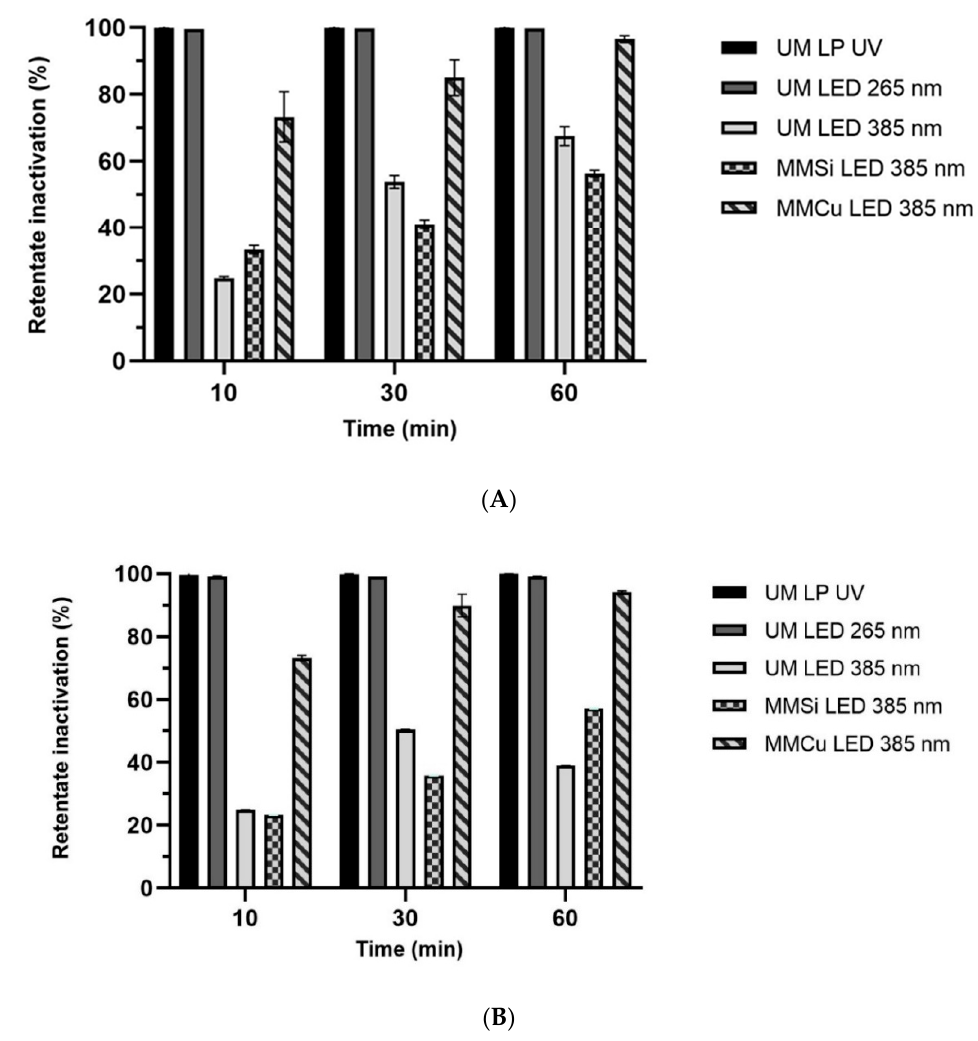
Figure 4. Retentate percent inactivation of total coliforms ( A ) and E. coli ( B ) present in surface water when filtration with the unmodified membrane (UM) was coupled with LP ‐ UV, UV ‐ C LEDs 265 nm and UV ‐ A LEDs 385 nm as well as when the modified (MM) membranes were coupled with UV ‐ A LED panels that emit light at 385 nm. Error bars represent duplicate results.